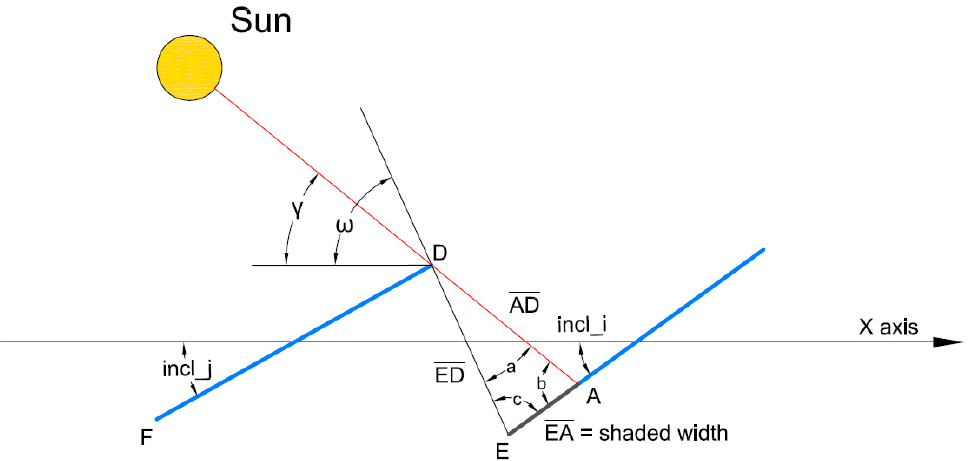
Figure 8. Both mirrors with negative inclination.